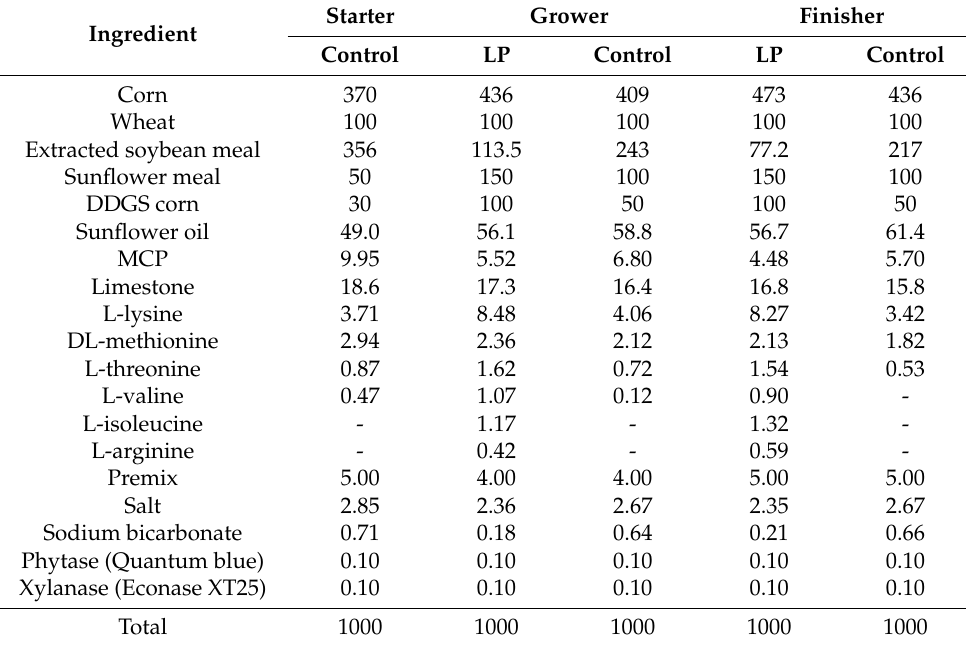
Sodium bicarbonate Phytase (Quantum blue)